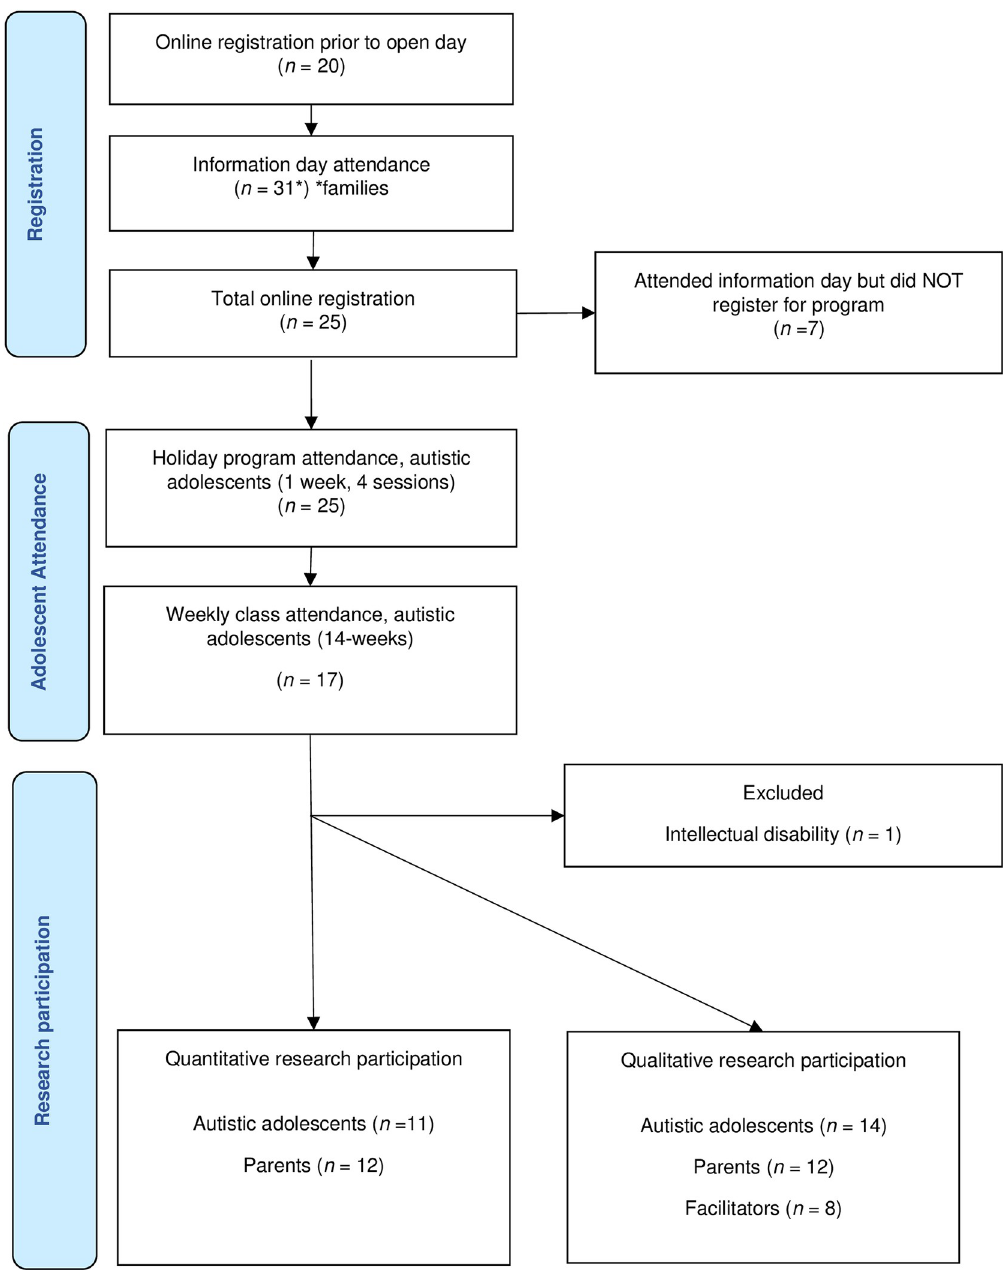
Fig 1. Participant participation and research recruitment